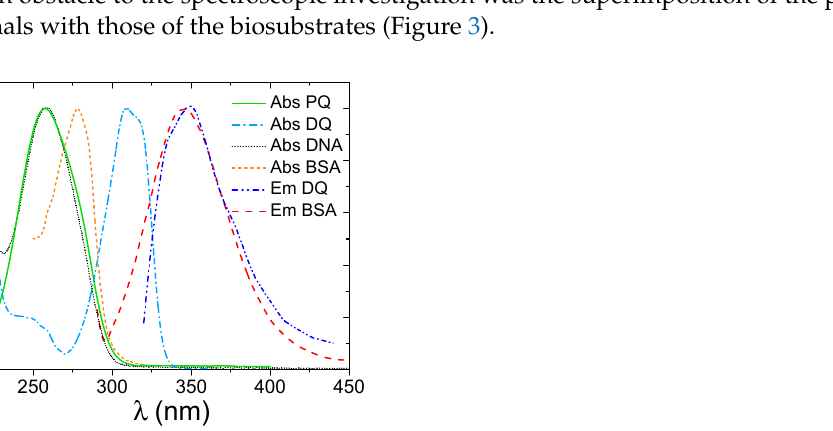
Figure 3. Normalized absorbance (Abs) and emission (Em) profiles of PQ, DQ and the biotargets. Under these circumstances, in the case of absorbance experiments, differential titrations may be performed: the same amount of the titrant (DNA) is added to both the measuring and the reference cell. Figure S1 (Supplementary Materials) shows an example of the spectra recorded for differential titrations. As far as the DNA content is raised and therefore high values of DNA absorbance are reached, this approach may be biased and thus not highly reliable. However, neither PQ nor DQ showed significant absorbance profile changes or bathochromic effects, even for the first steps of DNA additions. This finding may be the first hint of a scarce interaction between the herbicides and DNA. To overcome the problem, fluorescence exchange titrations with EtBr were performed where known amounts of herbicides were added directly to EtBr-saturated DNA. A decrease in emitted fluorescence at the excitation and emission wavelengths typical of intercalated EtBr would have indicated its displacement from the helix [51]. Although the selected herbicides present suitable features to be considered as DNA binders, the tests do not demonstrate any significant interaction (example in Figure S2), meaning that intercalation is excluded. Groove binding also seems unlikely, because the penetration within the groove (and even more of a charged species) is usually still able to produce some change in the EtBr probe environment which is reflected by a signal change [52]. The same conclusion emerges from the viscosity measurements carried out for the two herbicide/DNA systems at different herbicide/DNA (C D /C P ) ratios. The flow times (t) were used to calculate the relative viscosity according to Equation (1). For both herbicides, the relative viscosity remained almost constant upon the addition of increasing amounts of herbicide (Figure 4), indicating no significant elongation of the DNA helix. This result underlines the absence of intercalation between the DNA base pairs for both PQ and DQ.